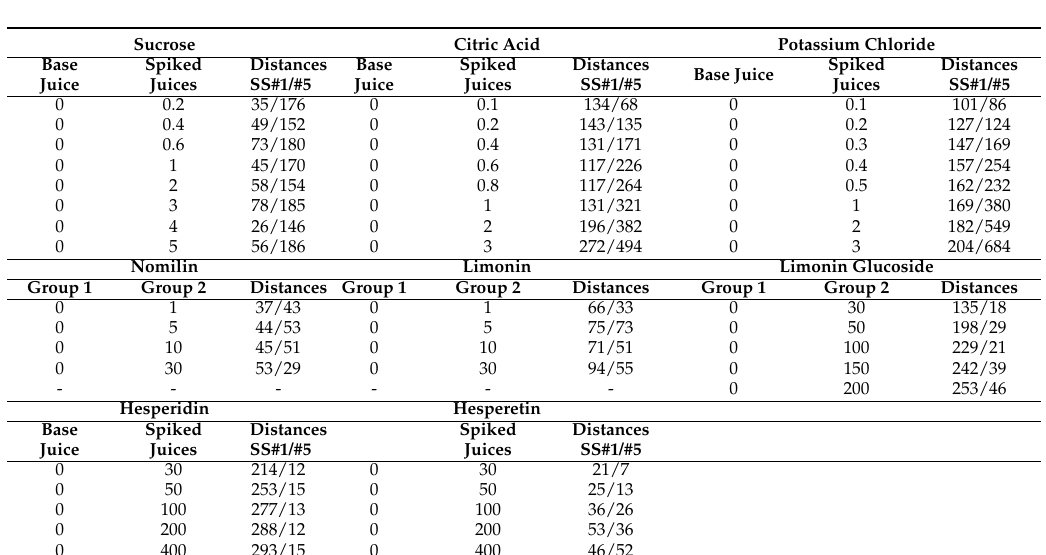
Table 2. Euclidean distances between unspiked base juice and spiked samples analyzed by electronic tongue sensor set (SS)